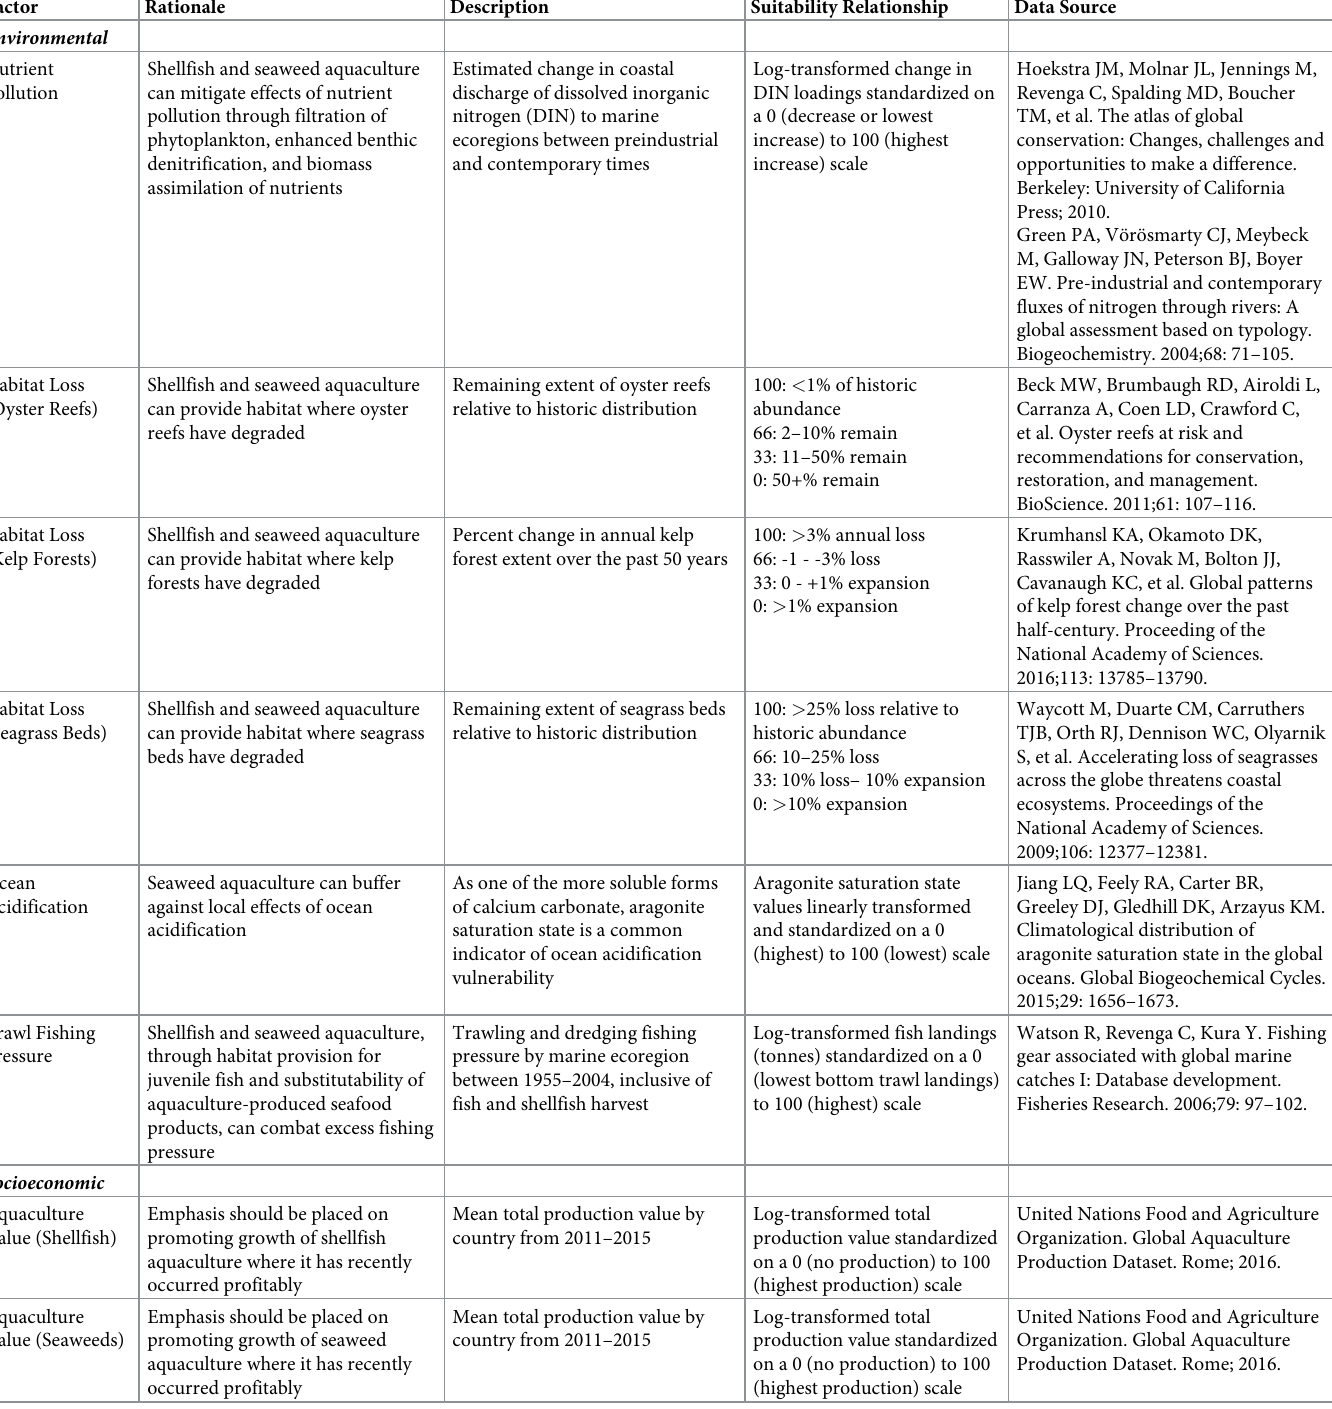
Table 1. List of 16 factors represented by spatial data layers used to determine high opportunity marine ecoregions for shellfish and seaweed restorative aquaculture development. A score of 100 denotes the highest opportunity for a given factor for restorative aquaculture, whereas a score of 0 denotes the lowest